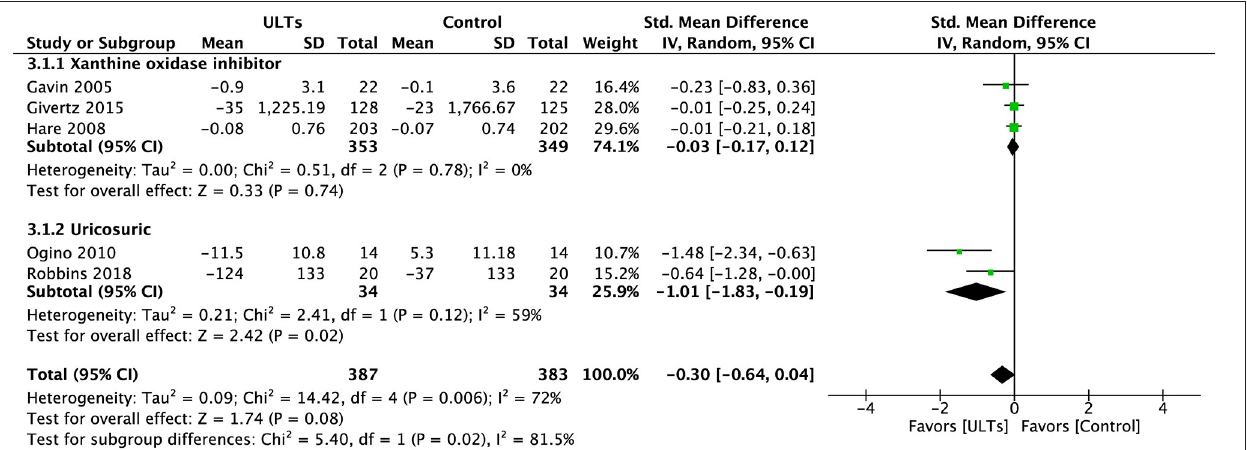
FIGURE 6 | Meta-analysis of B-type natriuretic peptide and N-terminal-pro-B-type natriuretic peptide.